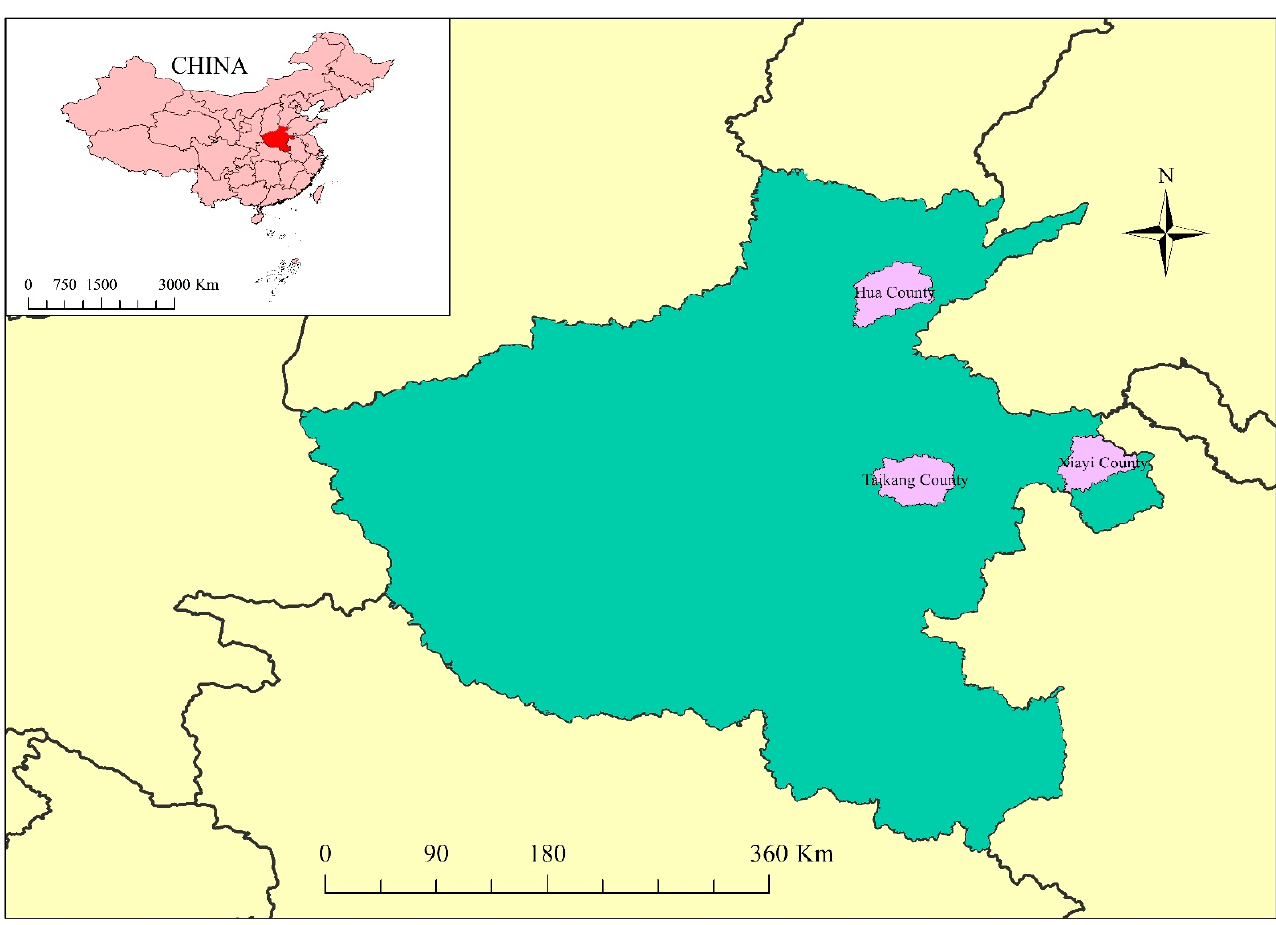
Figure 1. Location of the sample areas in this study.